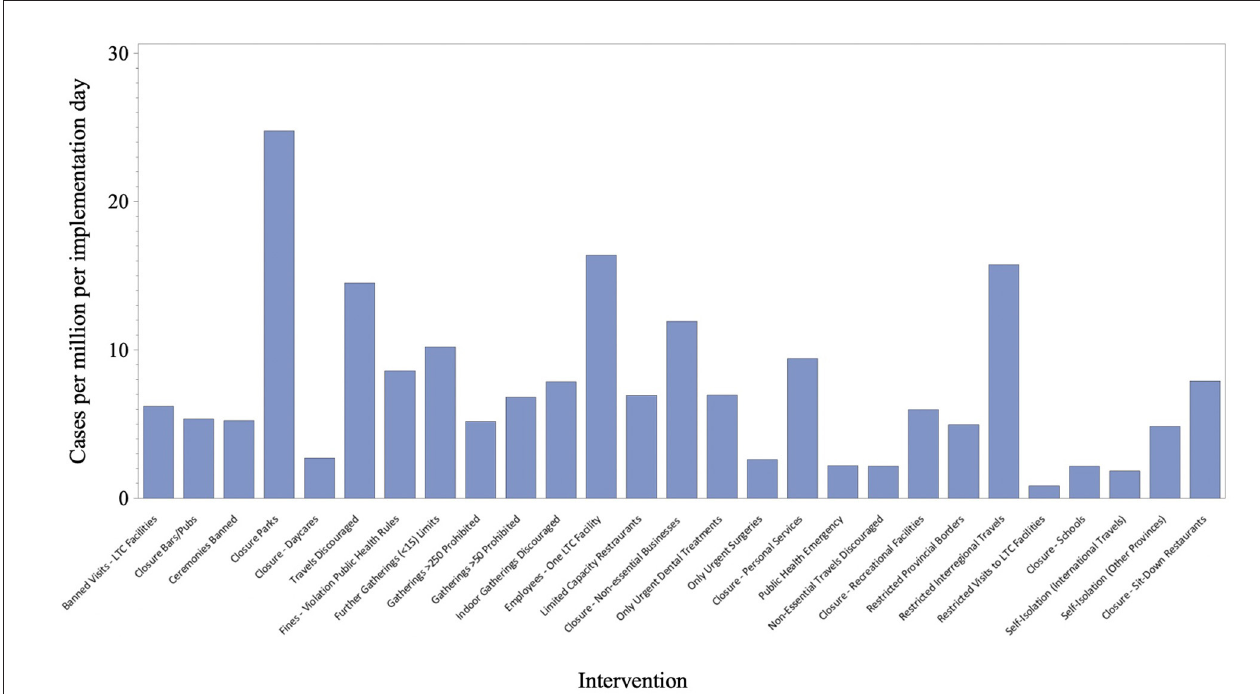
FIGURE 2 | Average cases per million per implementation